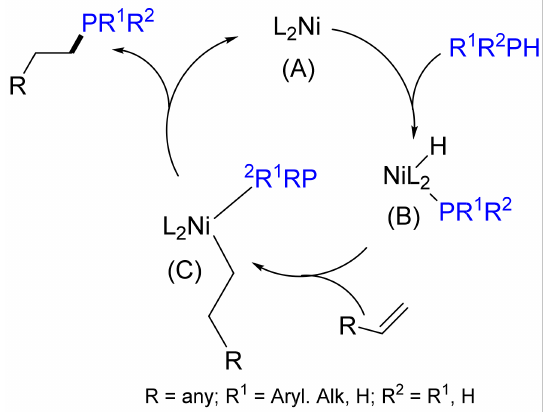
Figure 13. Mechanism of a Ni-catalyzed hydrophosphination of alkenes.